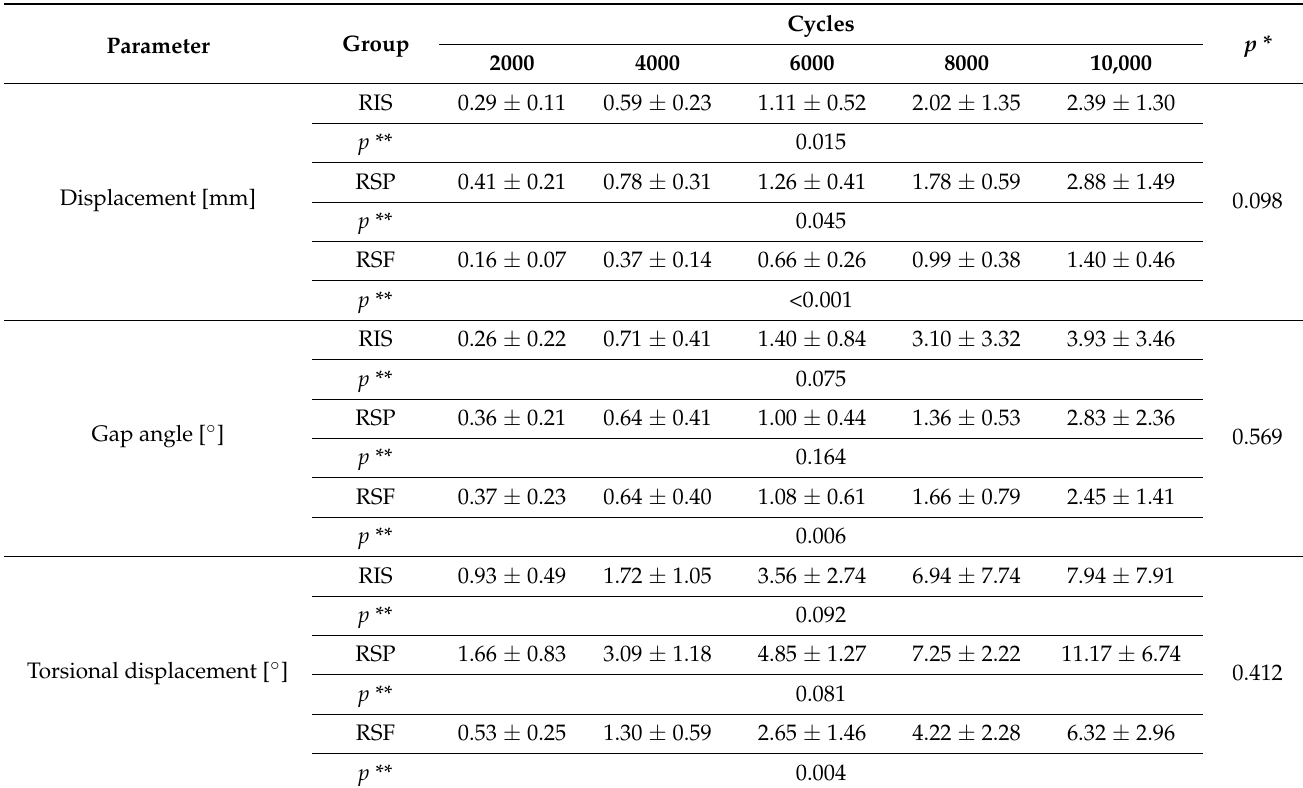
Table 1. Outcome measures of the parameters displacement, gap angle, and torsional displacement evaluated over the five time points after 2000, 4000, 6000, 8000, and 10,000 cycles, presented for each separate group (RIS, RSP, and RSF) in terms of mean value and standard deviation, together with p -values from the statistical comparisons among the groups ( p *) and over cycles ( p **).